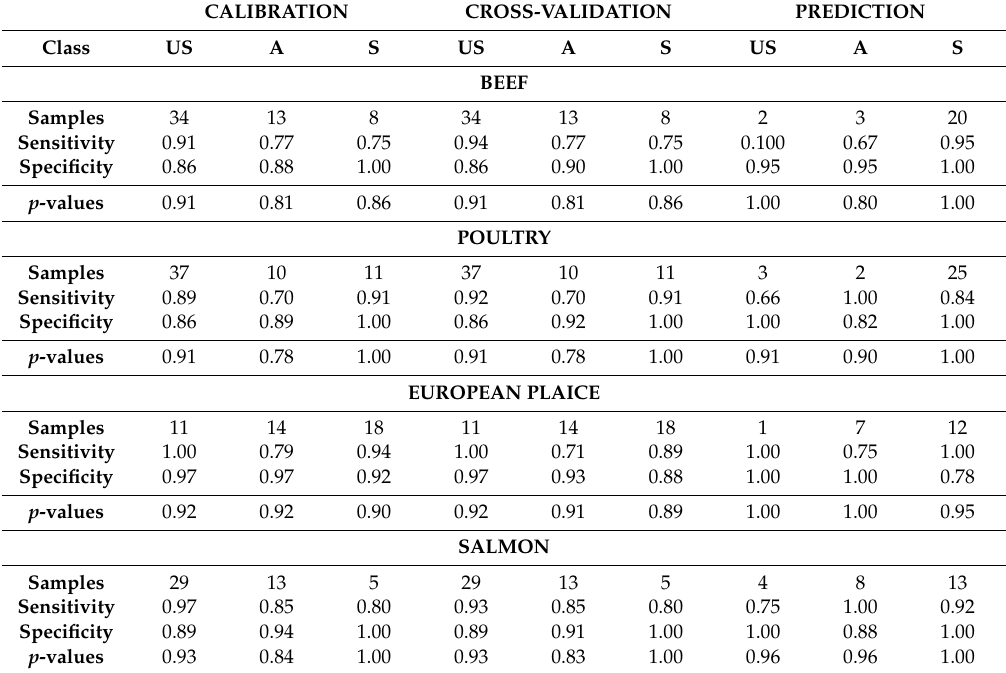
Figure 4. Principal Component Analysis-biplots of e-nose data collected on beef ( a ) poultry ( b ) plaice ( c ) and salmon ( d ) samples classified as unspoiled (US)-green; acceptable ( A )-yellow, spoiled ( S )-red. Table 7. Results of the K-NN models developed for the e-nose data collected for beef, poultry, European plaice, and salmon. Sensitivity, specificity percentage, and p-values obtained for each class (Unspoiled, US; Acceptable, A; Spoiled, S) in calibration, cross-validation, and prediction of the external test set. CALIBRATION